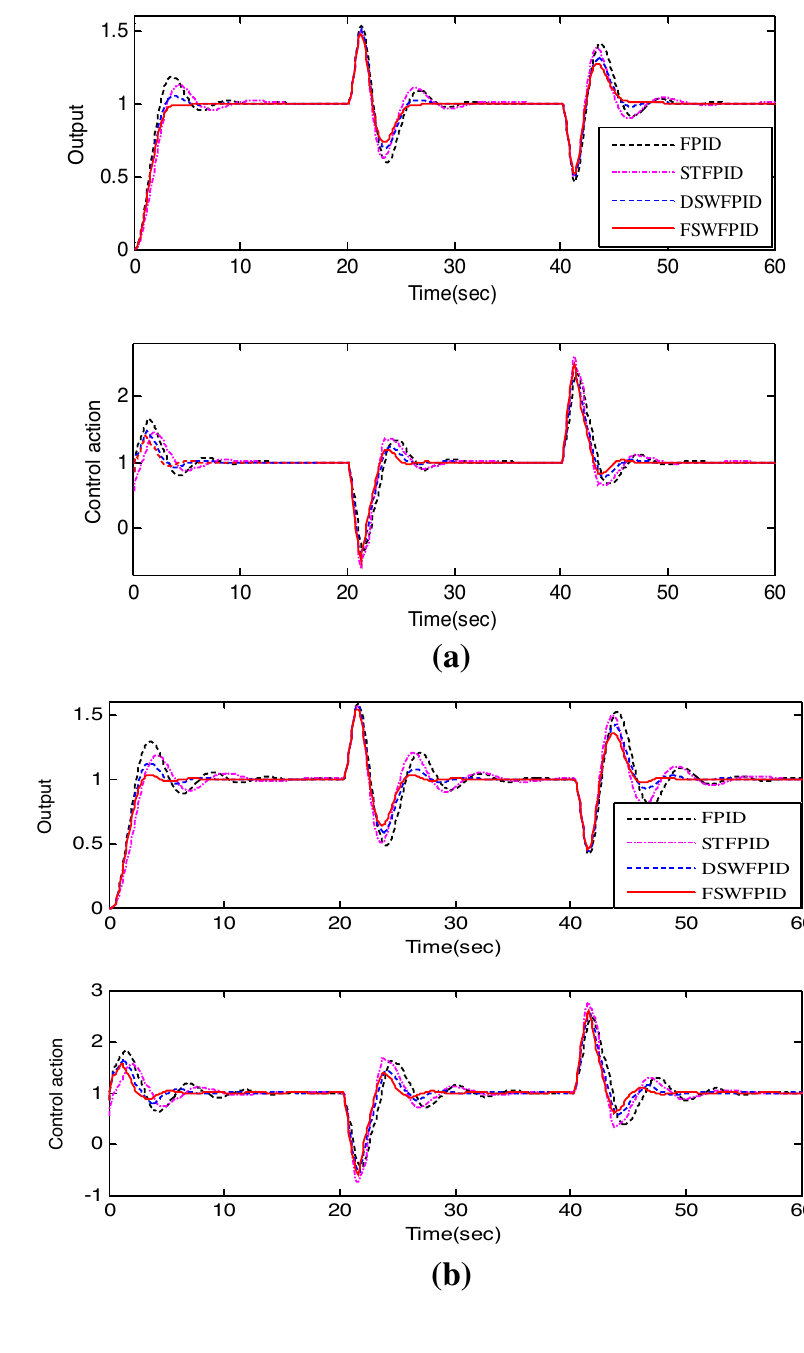
Fig. 11 Responses and control actions for Model II using 25 rules during set point response and with load variation for a L = 0.1 s, b L = 0.3